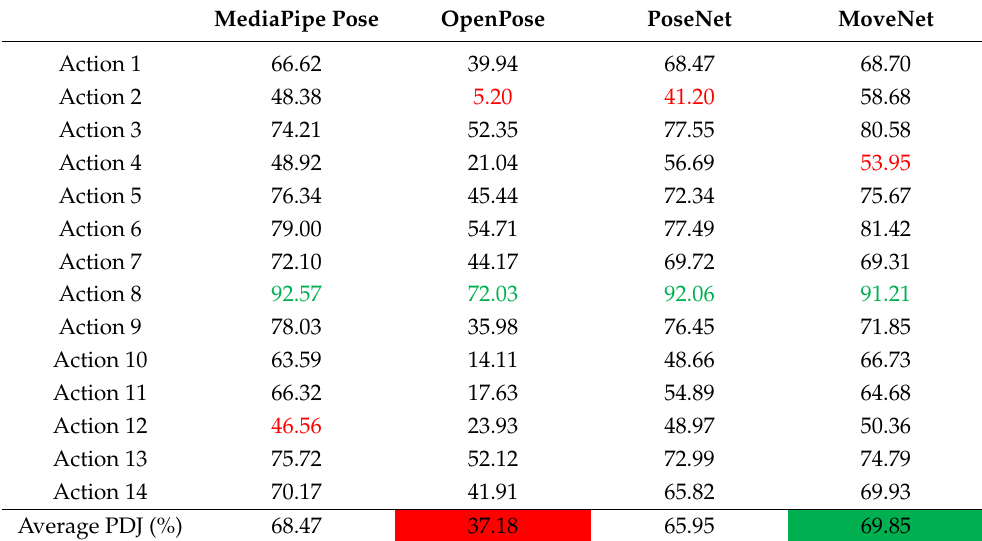
Table 6. Overall average of PDJ (%) in each action. MediaPipe Pose OpenPose PoseNet